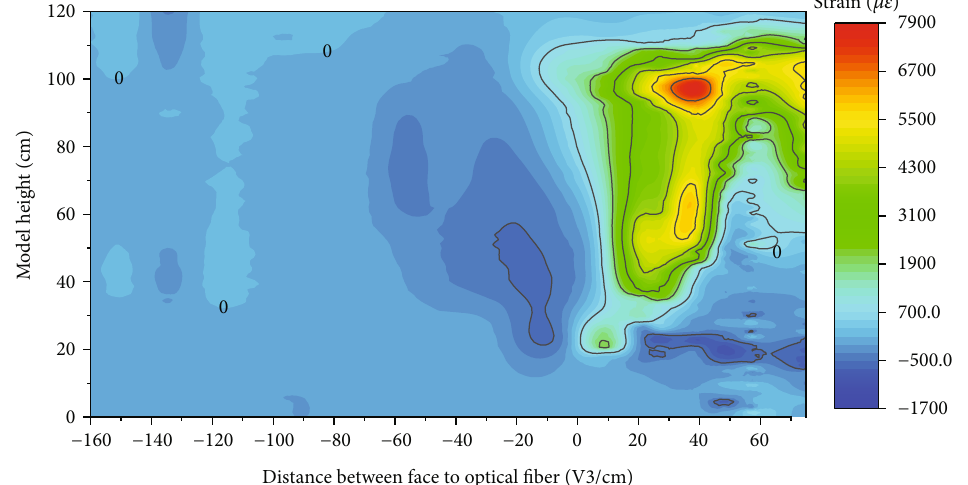
Figure 6: Strain distribution of fi ber V3 during the mining of coal seam 2 -2 (the abscissa is the model height, and the ordinate is the distance between the face and the optical fi ber).